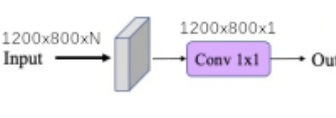
Figure 3. Linear combination model.